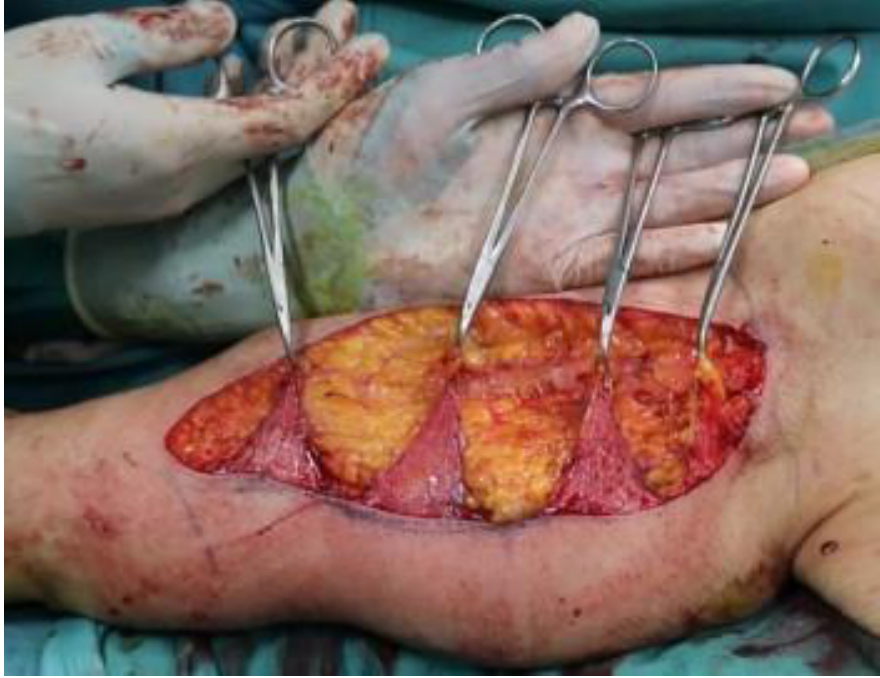
Figure 2. The dermal flaps. The shark jaw-like appearance of this step of our surgical procedure led us to name the technique the “Jaws brachioplasty”.